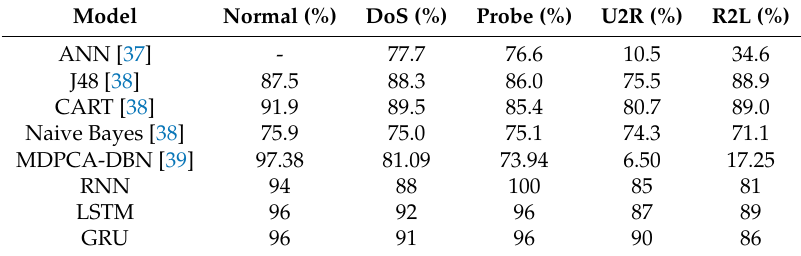
Table 6. Comparison accuracy detection of attack types on NSL-KDD dataset.